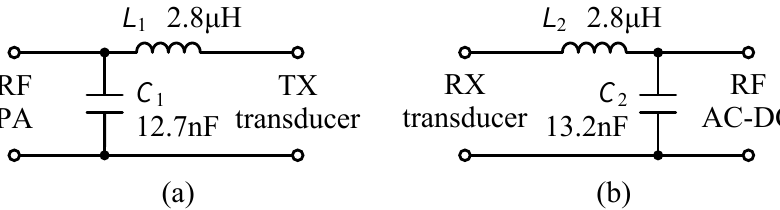
Figure 7. Matching network topology and component values: ( a ) TX matching network; ( b ) RX matching network.